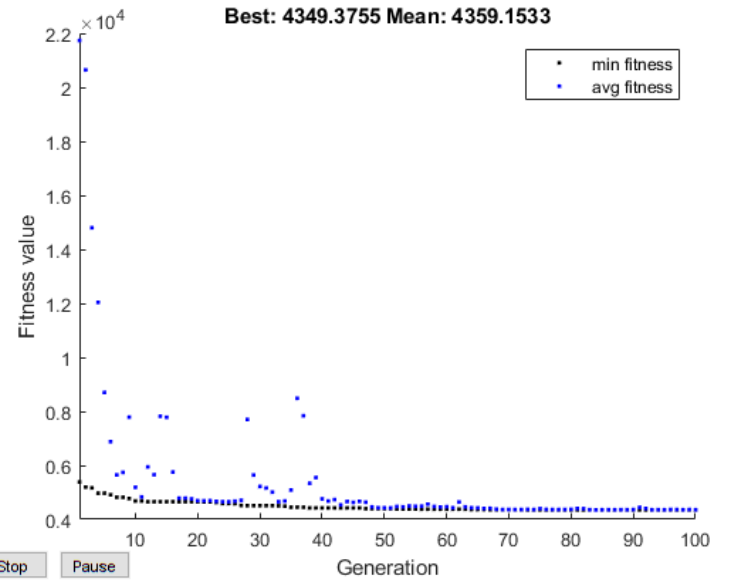
Figure 23. Best and average fitness evolution in control strategy #5 when minimizing OQI. Table 16. Simulation results when the overflow quality index is minimized (strategy #5). Tank